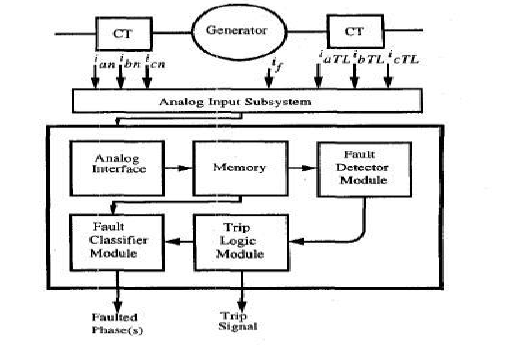
Figure 2 . an algorithm for simulating interior blames in the synchronous generator of Fig. 1